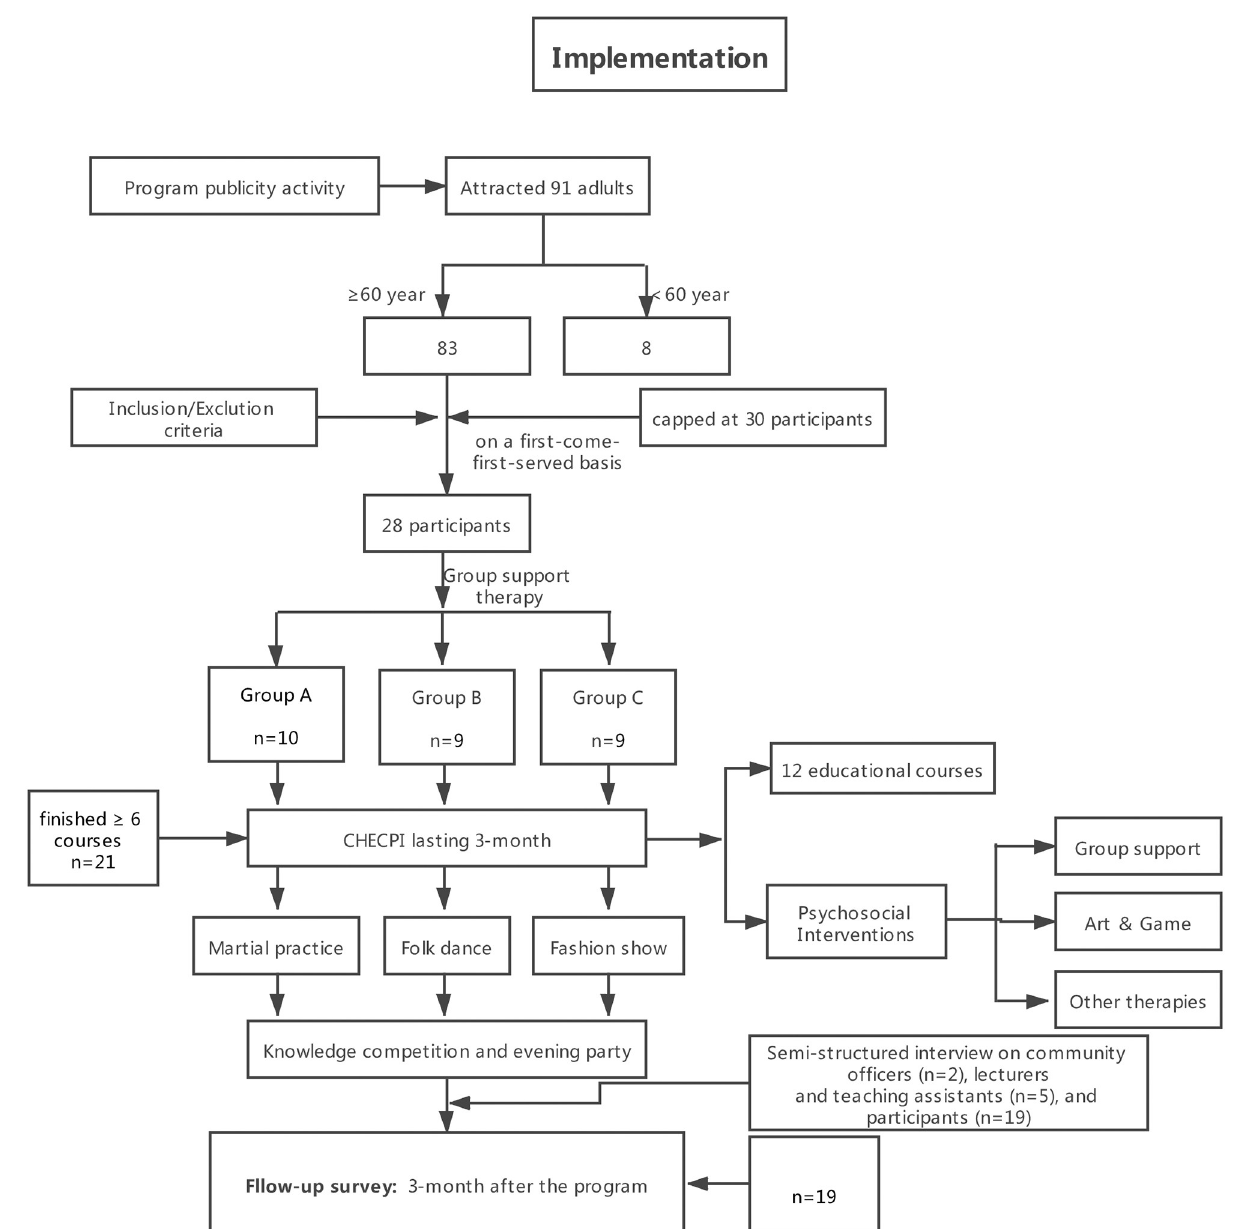
Fig 1. Implementation of cognitive health education combined with psychosocial interventions (CHECPI). Each course consisted of content teaching (45 mins) and different kinds of psychosocial interventions (15 mins). Martial Arts Practice, Folk Dance, and Fashion Show were the performances prepared by different groups for the final